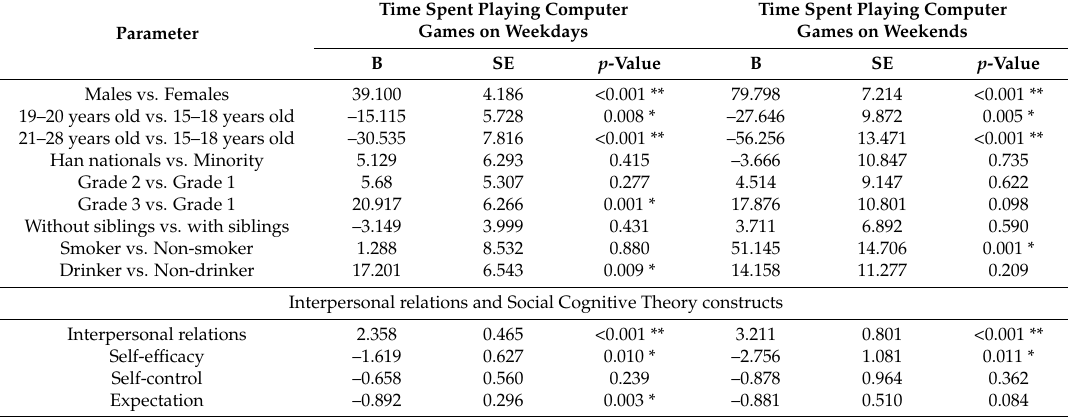
Table 5. Generalised linear model analysis of factors that affect interpersonal relations and social cognitive theory constructs of time spent playing computer games among all participants in Chongqing,